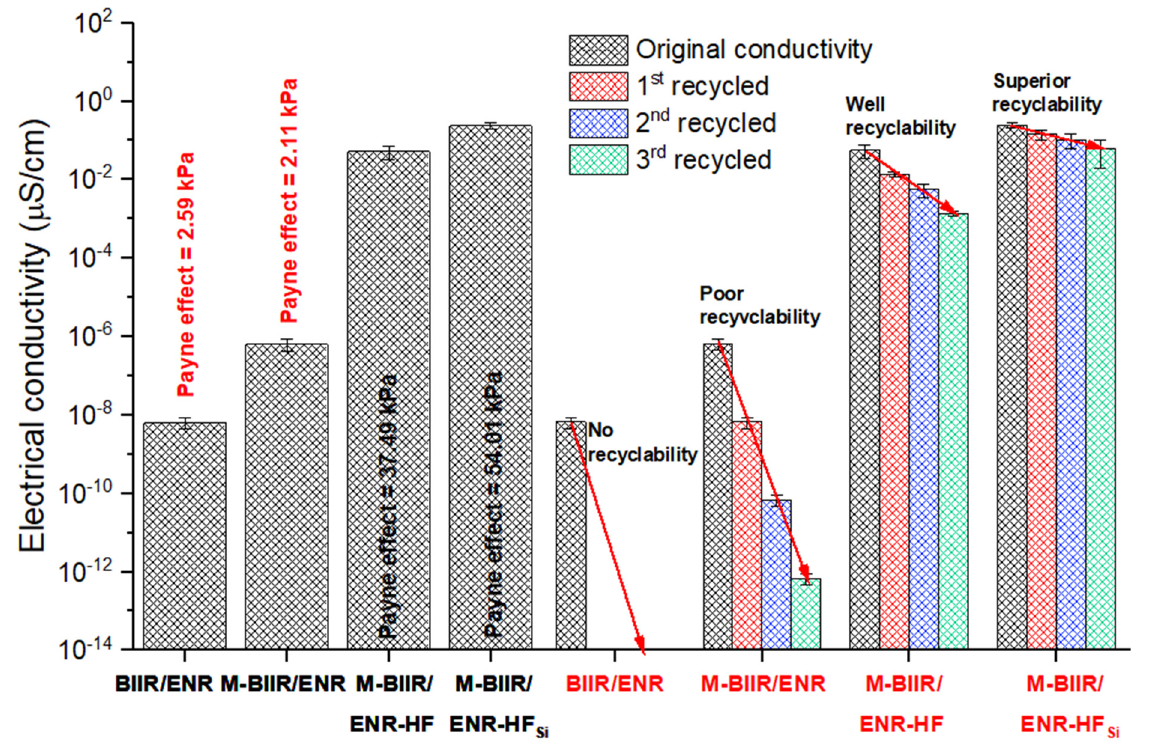
Figure 10. Electrical conductivity of unmodified BIIR and the M-BIIR/ENR composites filled with CNT/CB with and without the addition of TESPT.